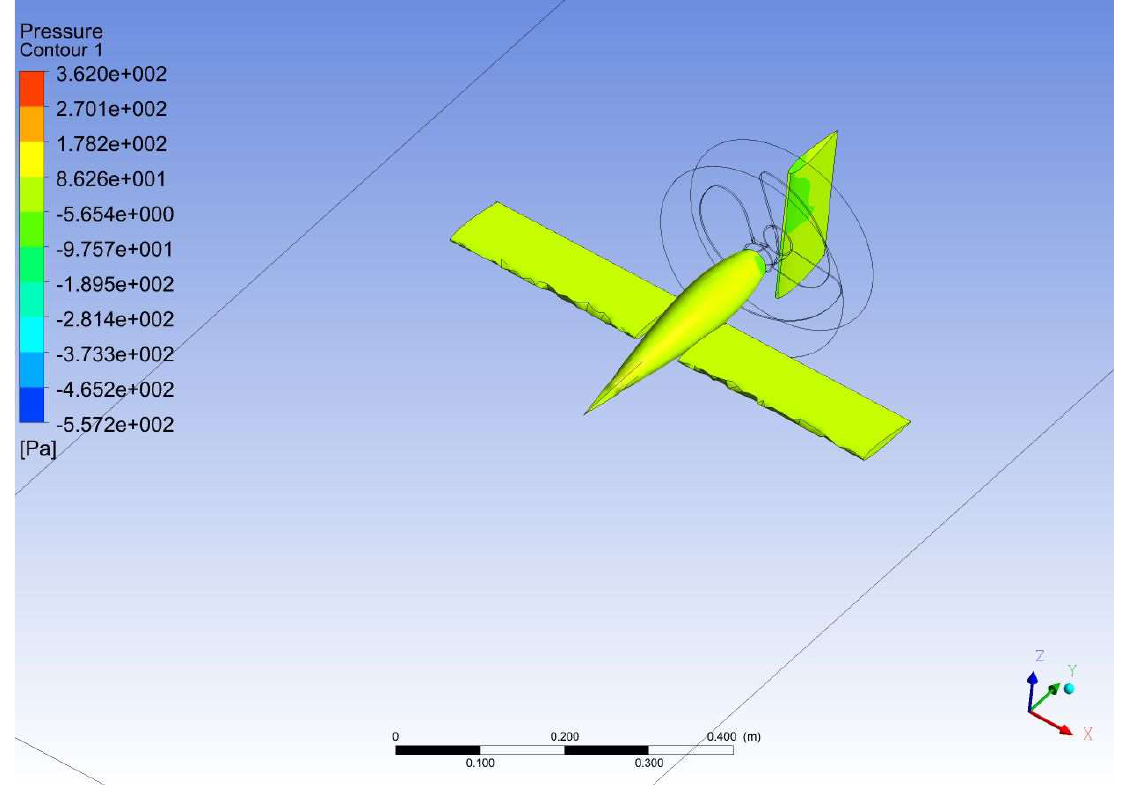
Aerospace 2022 , 9 , x FOR PEER REVIEW Figure 39. Aerodynamic Pressure distributions on US—steady level flight. Figure 39. Aerodynamic Pressure distributions on US—steady level flight.